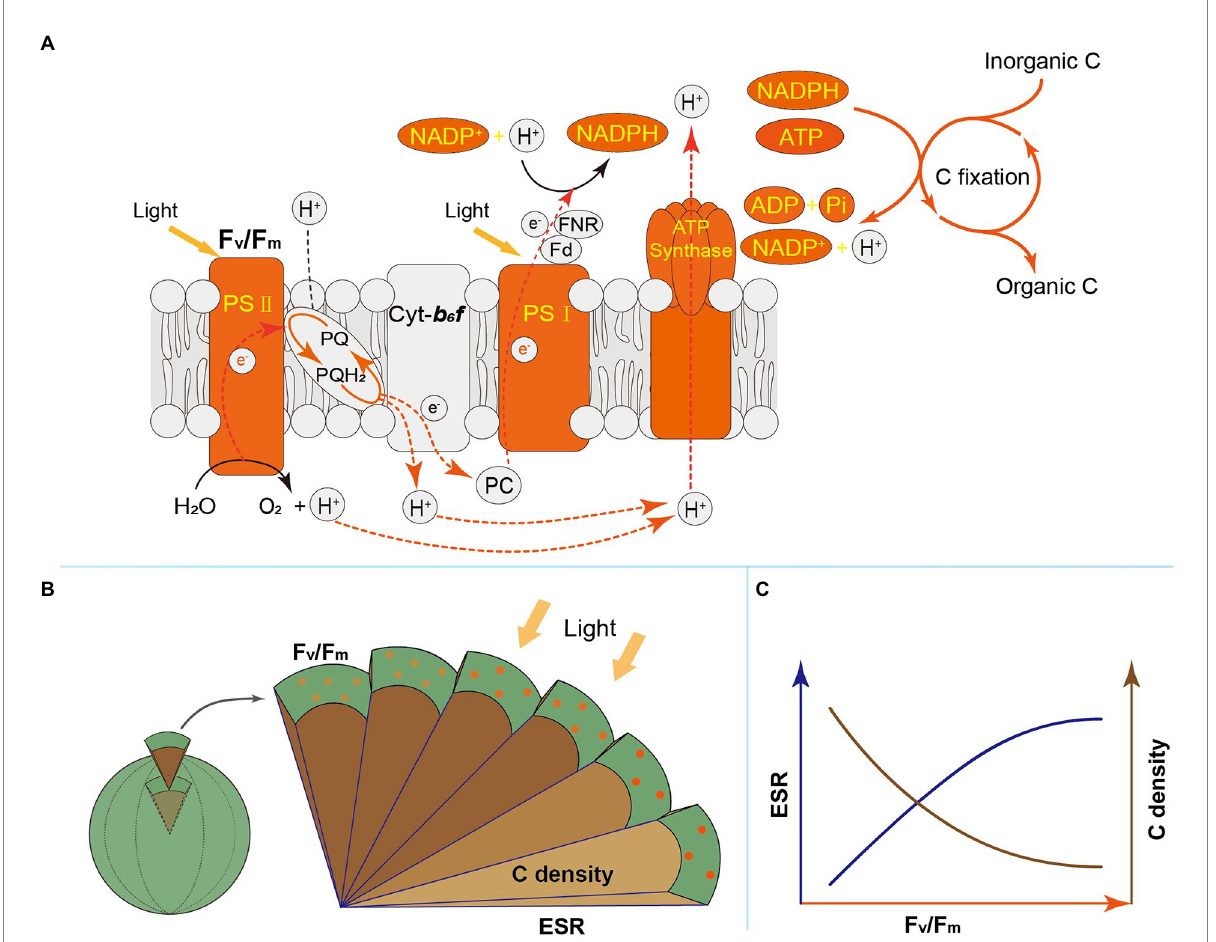
FIGURE 7 (A) Schematic diagram for photosynthesis and carbon fixation in phytoplankton cells. The orange marks represent the regulation pathways that is highlighted in this study. (B) Schematic diagram for regulation of light energy utilization on cell size of phytoplankton. The circles on the surface: the chlorophyll molecules. F v / F m : the maximum quantum yield of Photosystem II, marked by orange; ESR: equivalent spherical radius, marked by dark blue; C density: carbon density, marked by brown. A gradual increase in color indicates higher values of F v /F m and C density; with